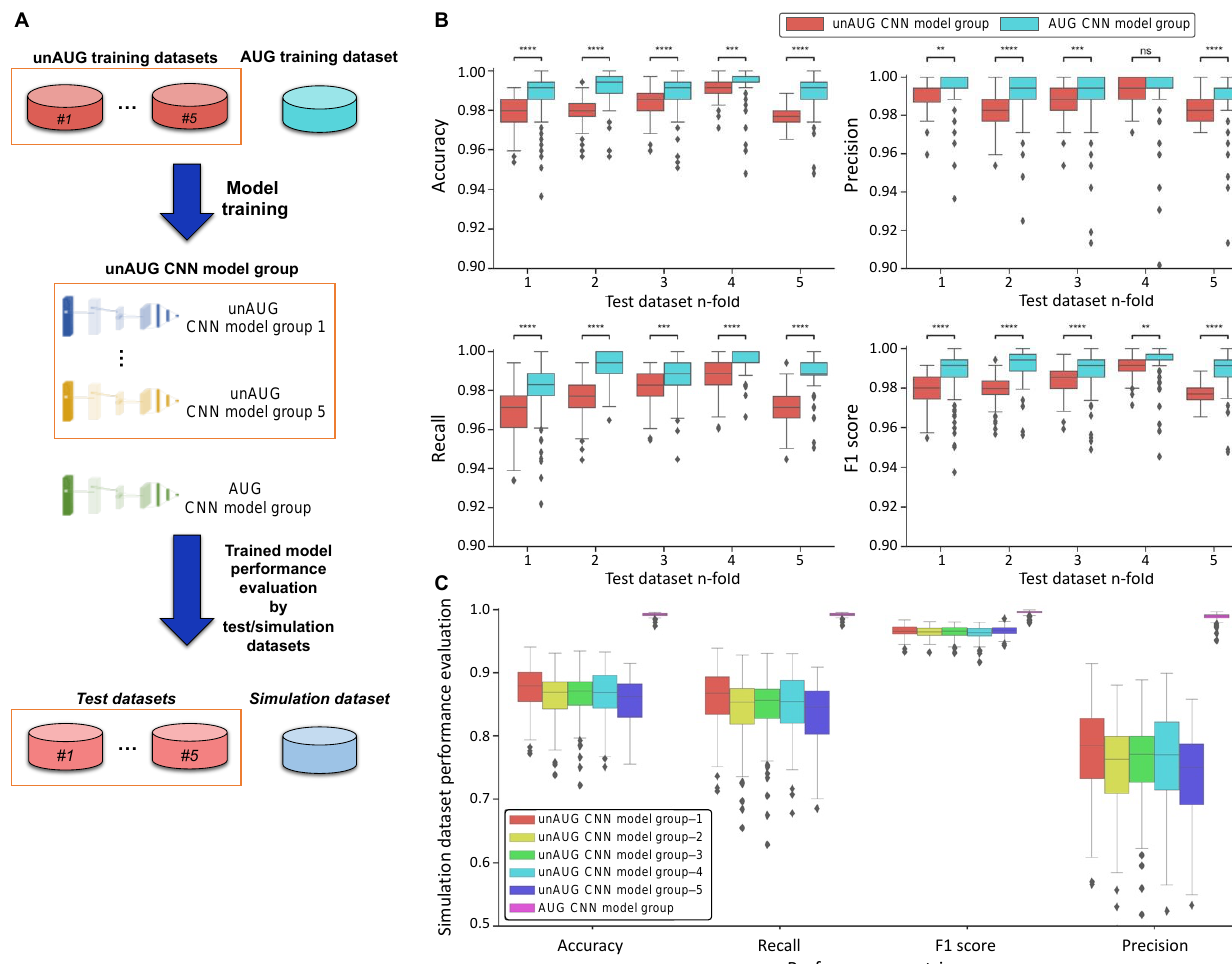
Figure 2. Prediction results of the CNN models using test and simulation datasets. ( A ) CNN models were trained by AUG and unAUG training datasets. Trained model performances were evaluated based on 5-fold of test datasets and a simulation dataset. ( B ) The performance results of test dataset prediction are represented in boxplots. The prediction performances of unAUG and AUG CNN models were compared by four performance metrics of accuracy, precision, recall, and F 1 scores (** p < 0.01, *** p < 0.001, **** p ≤ 0.0001). ( C ) Boxplots showing simulation dataset prediction performance results. The prediction performance of the models was compared with the above four performance